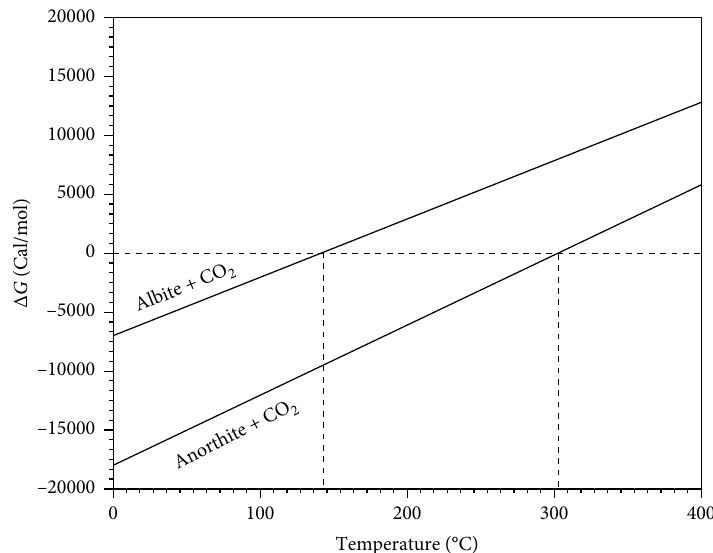
= 100 bar; modi fi ed after co2